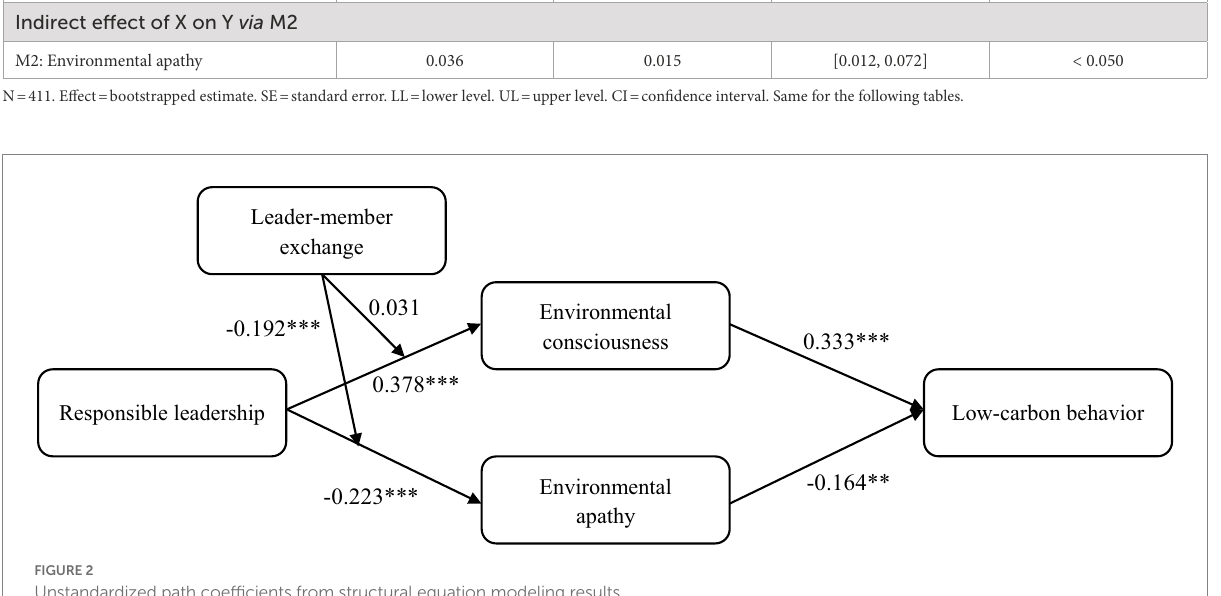
(Table 4). For environmental consciousness, the indirect effect is 0.126 (95% CI = [0.078, 0.184]); for environmental apathy,